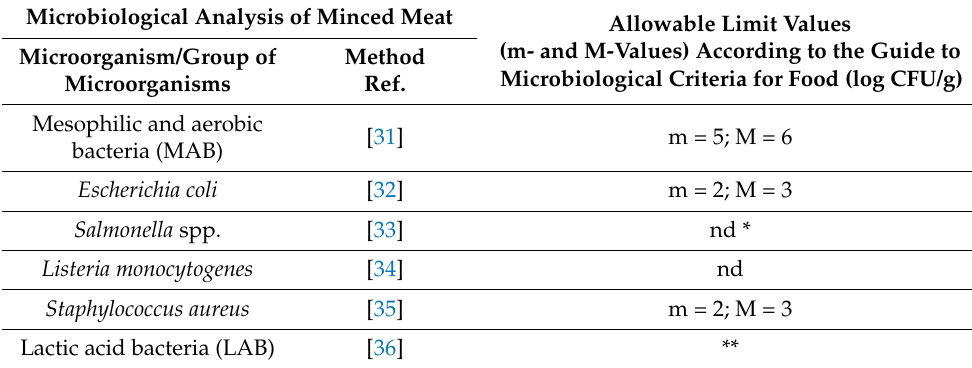
Table 1. ISO methods for microbiological